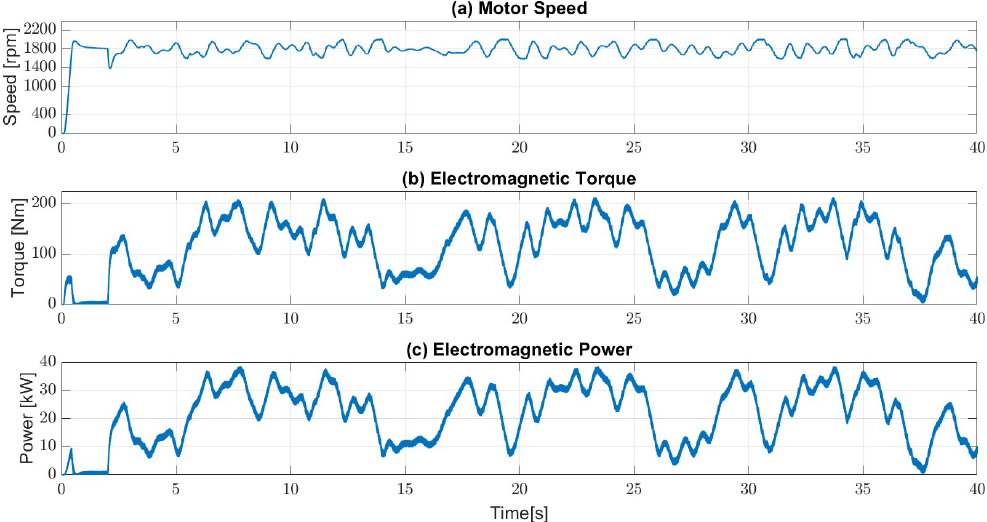
Figure 22. PMSM variables: ( a ) rotor speed; ( b ) electromagnetic torque; ( c ) electromagnetic